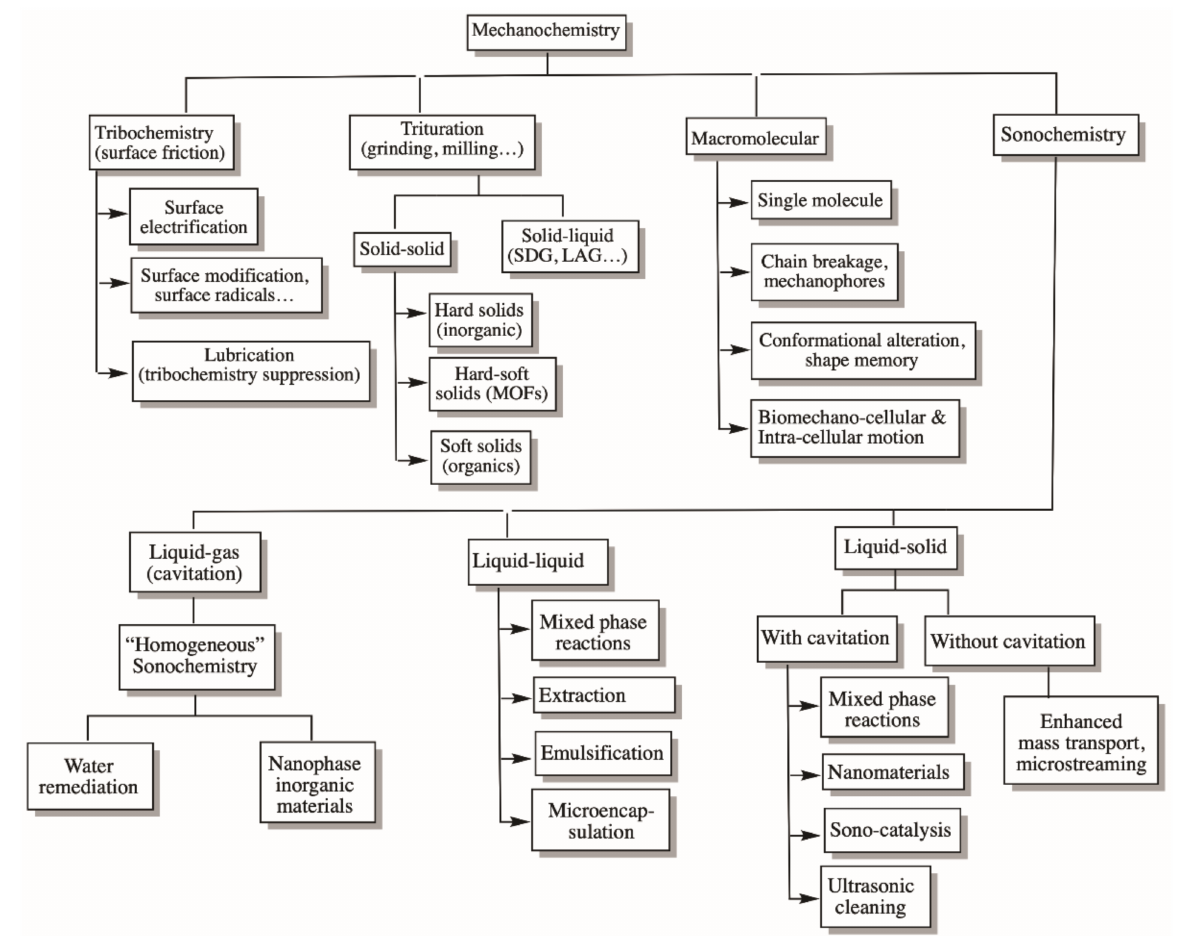
Figure 3. Different branches derived from the mechanochemistry. Adapted with permission from [80], Royal Society of Chemistry, 2014. SDG: solvent drop-grinding; LAG: liquid-assisted grinding; MOFs: metal-organic